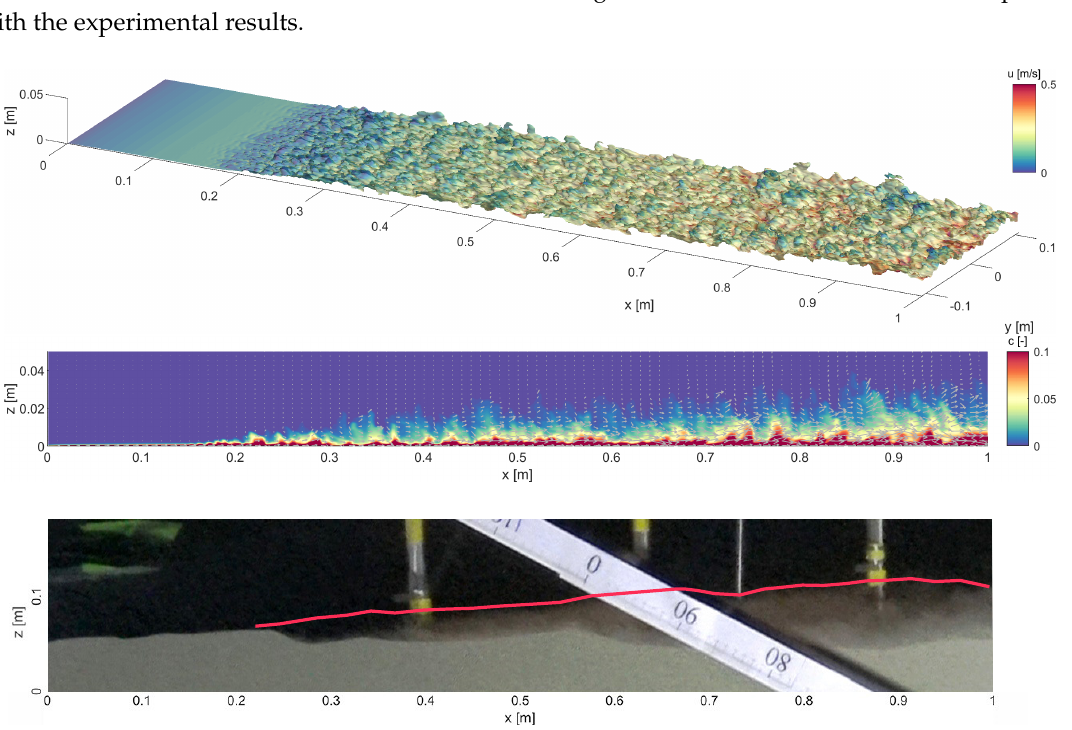
Figure 5. An instantaneous 3D view of the isosurface c = 0.01 at time = 8 s (Run 3); colors indicate the magnitude of the streamwise velocity ( top ). An instantaneous 2D vertical slice at y = 0 at time = 8 s (Run 3); colors indicate the magnitude of the sediment concentration c and vectors indicate the magnitude and direction of the streamwise and bed-normal velocities in this plane ( middle ). An instantaneous, experimental side view of the spatial development of the flow over a 64 ◦ breach face [18]; the flow propagates from left to right and the red line corresponds to the visual upper boundary of the flow ( bottom